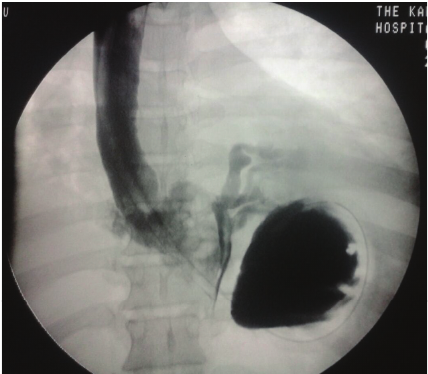
Figure 1: Gastrografin swallow showing leak of contrast into the left mediastinum and left pleural cavity.